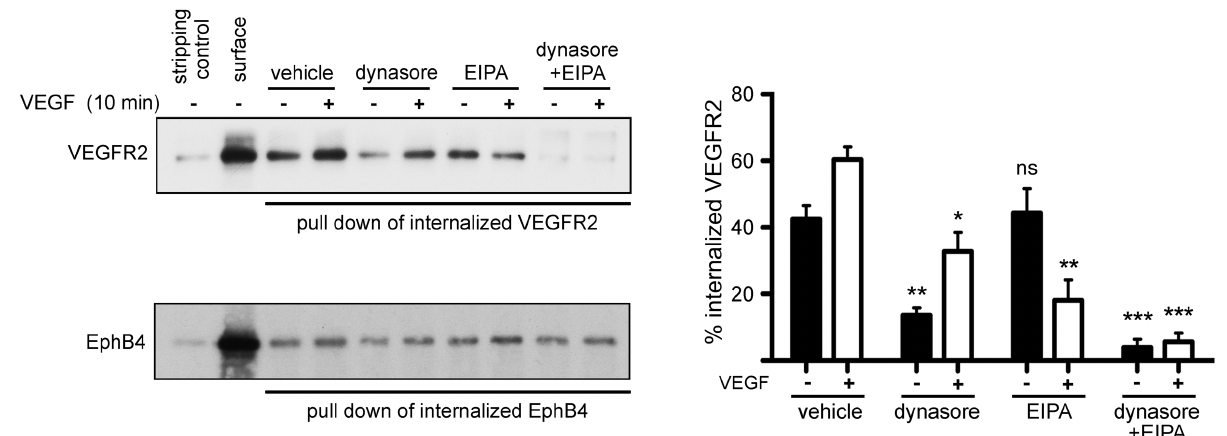
Figure 3. Analysis of VEGFR2 internalization routes, using biotinylation of plasma membrane proteins. Surface proteins of HUVECs were labeled at 4 °C with cell-impermeable, cleavable biotin. Then, the cells were treated with vehicle or inhibitors of endocytosis (dynasore, EIPA or dynasore + EIPA) for 30 min, followed by incubation in the presence or absence of VEGF at 37 °C for 10 min (to allow internalization). Surface biotin was cleaved, and internalized biotinylated proteins were pulled down using streptavidin beads and processed for Western blotting analysis. Internalized biotinylated VEGFR2 or biotinylated EphB4 was revealed by anti-VEGFR2 or anti-EphB4 antibodies, respectively. Quantification of internalized VEGFR2 is shown on the right of the immunoblot (n = 3 independent experiments, mean ± S.D., * p < 0.05, ** p < 0.01, *** p < 0.001, t -test).